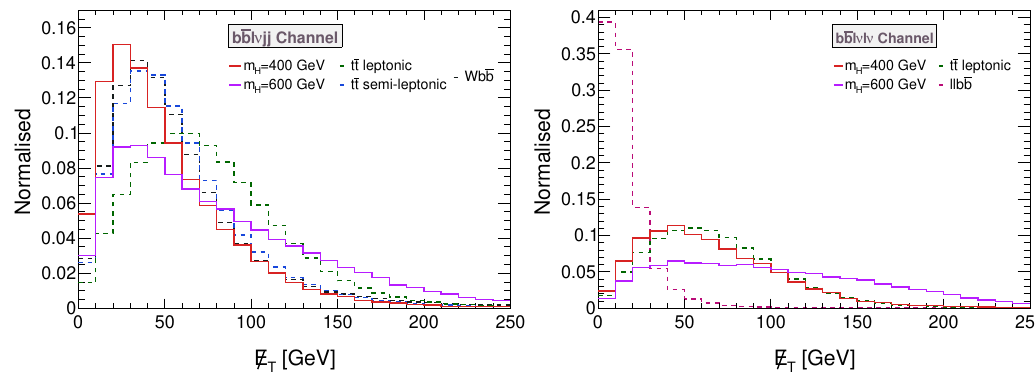
Figure 18 . The =E T distributions for the 1 ‘ and 2 ‘ categories for m H = 400 and 600 GeV with dominant backgrounds. Here the heavy Higgs boson is searched for in the bbWW (cid:3) channel. The distributions are shown after imposing the basic trigger